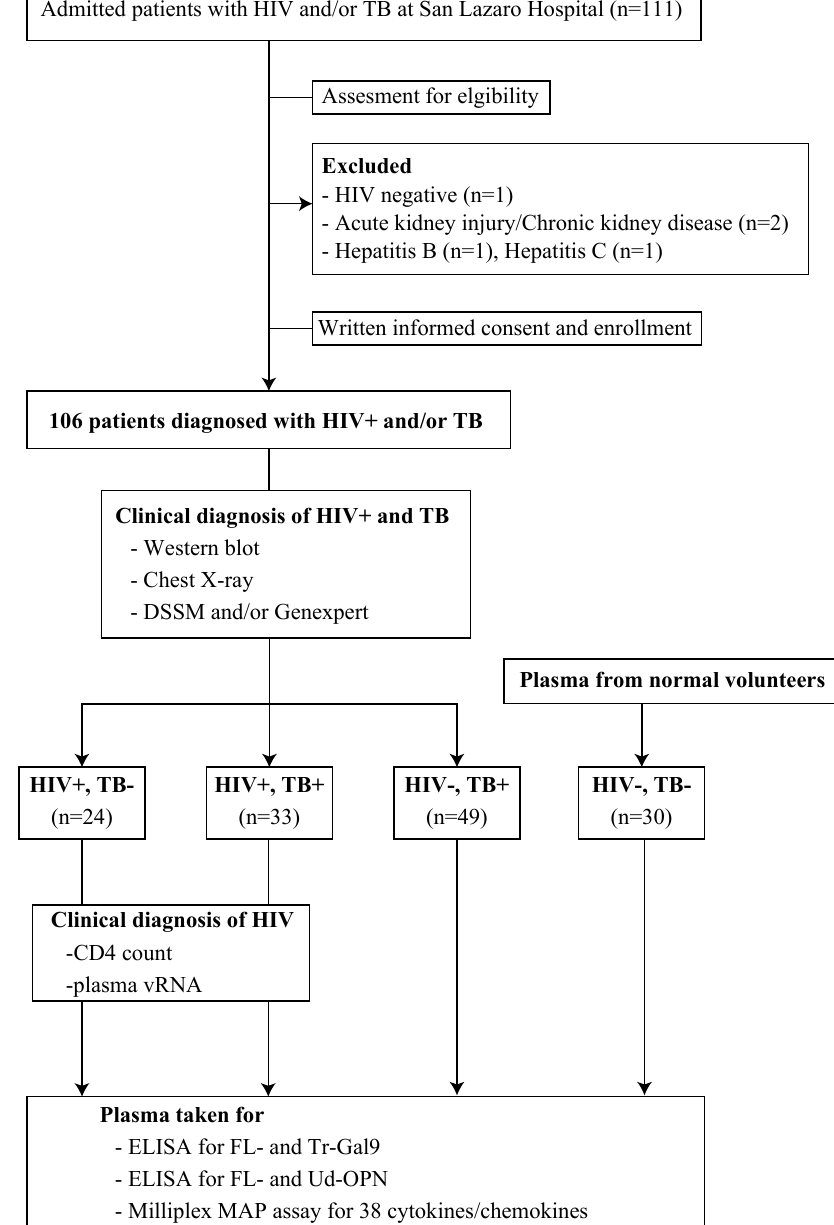
Figure 1. Study flowchart. Adult patients admitted with TB or HIV at San Lazaro Hospital were screened for eligibility. Eligible patients who met the inclusion criteria were randomly selected. A total of 106 patients were enrolled, 24 had HIV with a CD4 count of <200 cells/µL, 49 had TB, and 33 had AIDS/TB. Tuberculosis was microbiologically diagnosed using direct sputum smear microscopy and/or Genexpert, or clinically, using WHO signs and symptoms. All AIDS patients had never been on antiretroviral therapy and suffered from various OIs, as detailed in the Materials and Methods. Table 1. Characteristics of AIDS, TB, and AIDS/TB patients.